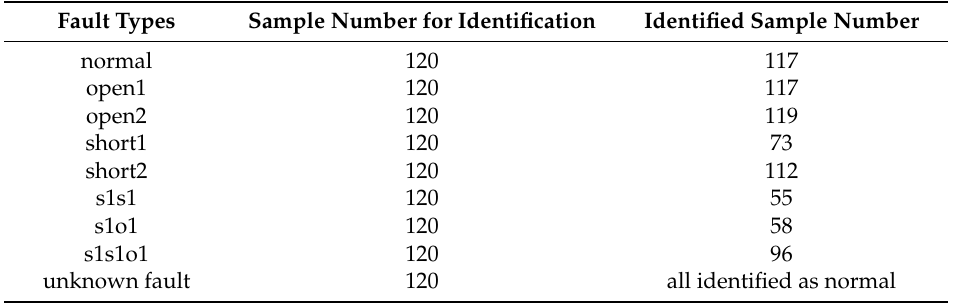
all identified as normal